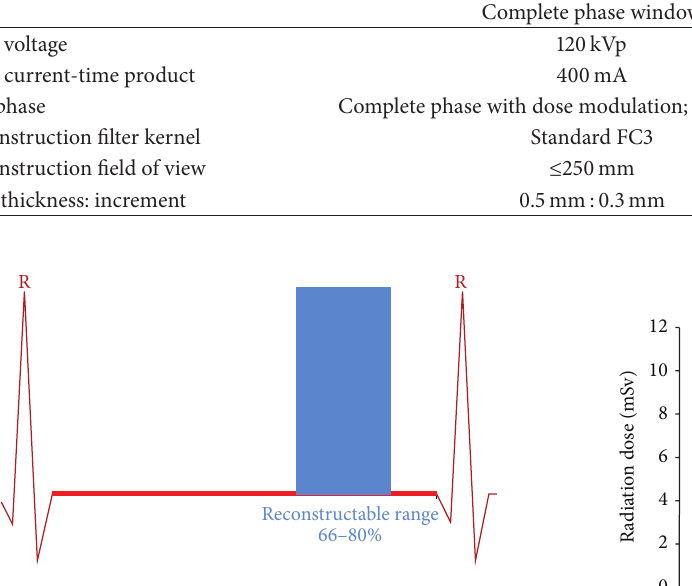
Figure 1: Narrow phase window (66–80) showing limited tube current exposure, 72 × 29mm (300 × 300DPI).